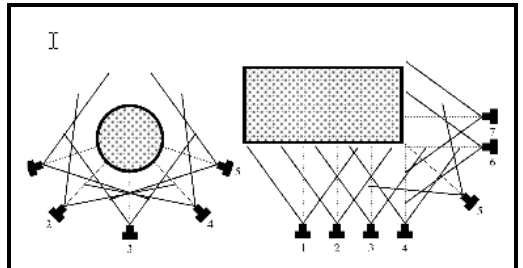
Figure 4: Examples for Terrestrial Photogrammetry